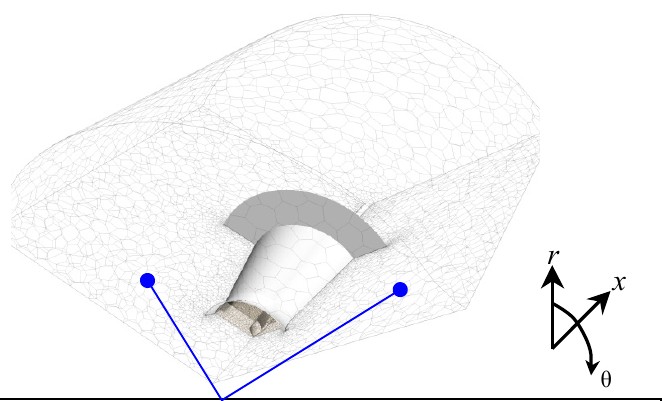
Figure 4. Simulation region of the long-type Wind-Lens turbine. x : inflow direction; r : radial direction; θ : circumferential